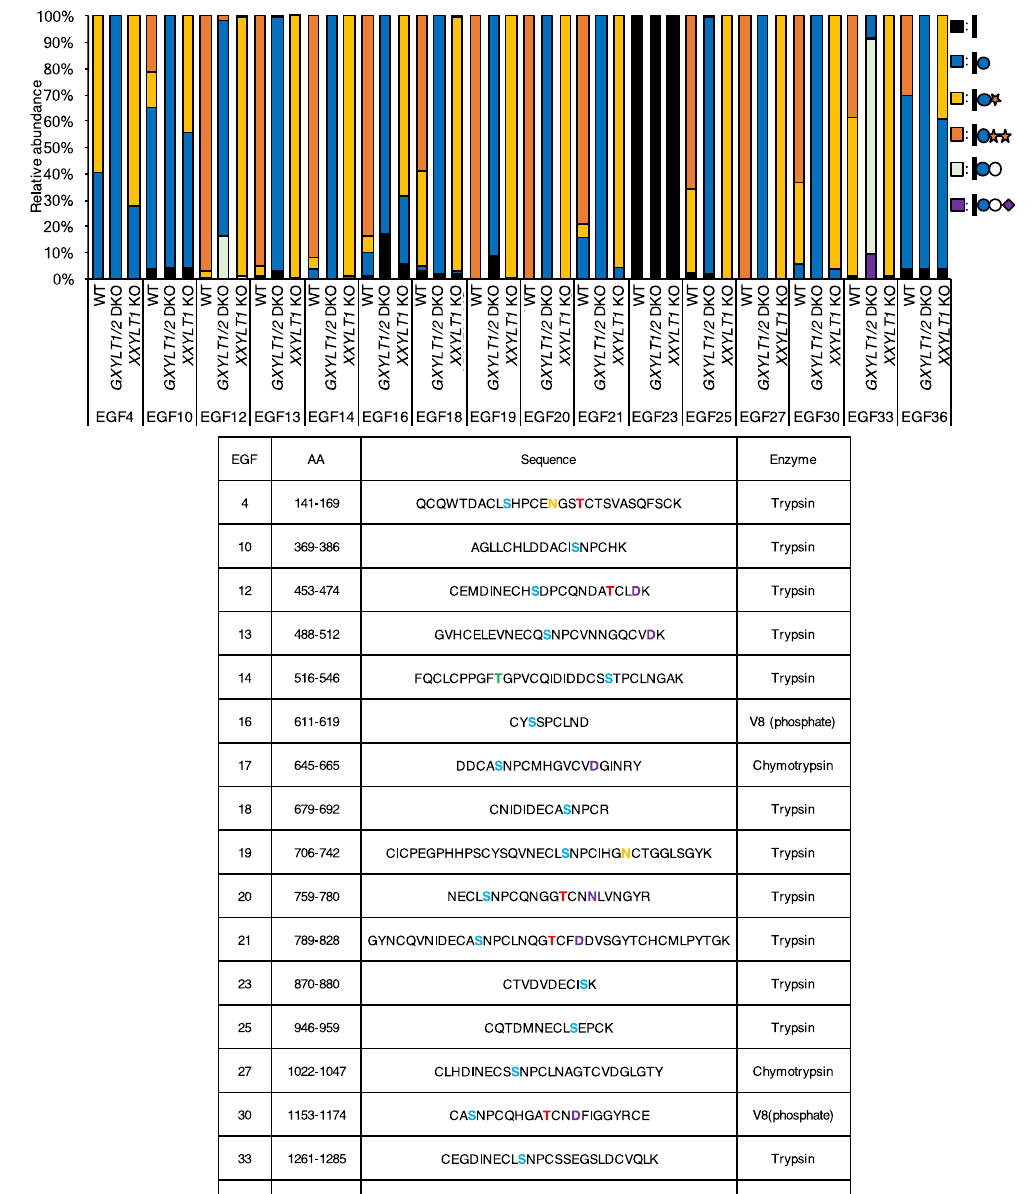
Figure 3. EGF repeats from NOTCH2 are modified with O -Glc trisaccharides . Mass spectrometric analysis of O -Glc glycans on mouse NOTCH2 produced in HEK293T cells. Samples were generated in wild type control HEK293T cells, GXYLT1 / 2 DKO cells, and XXYLT1 KO cells transfected with